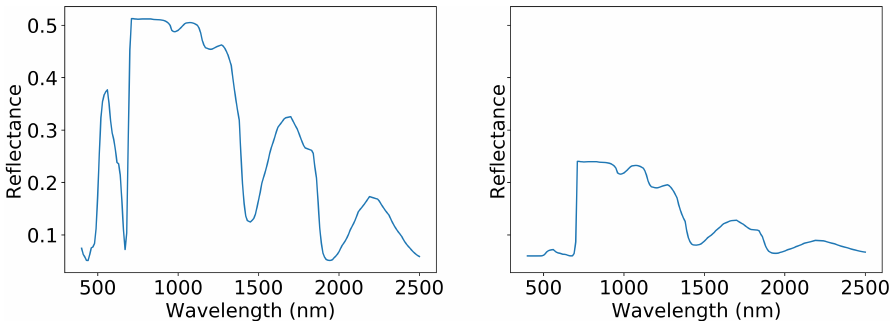
Figure 2. Two spectra produced with SLOP. The graph on the left is produced with minimum values from Table 1 while the graph on the right is produced with maximum